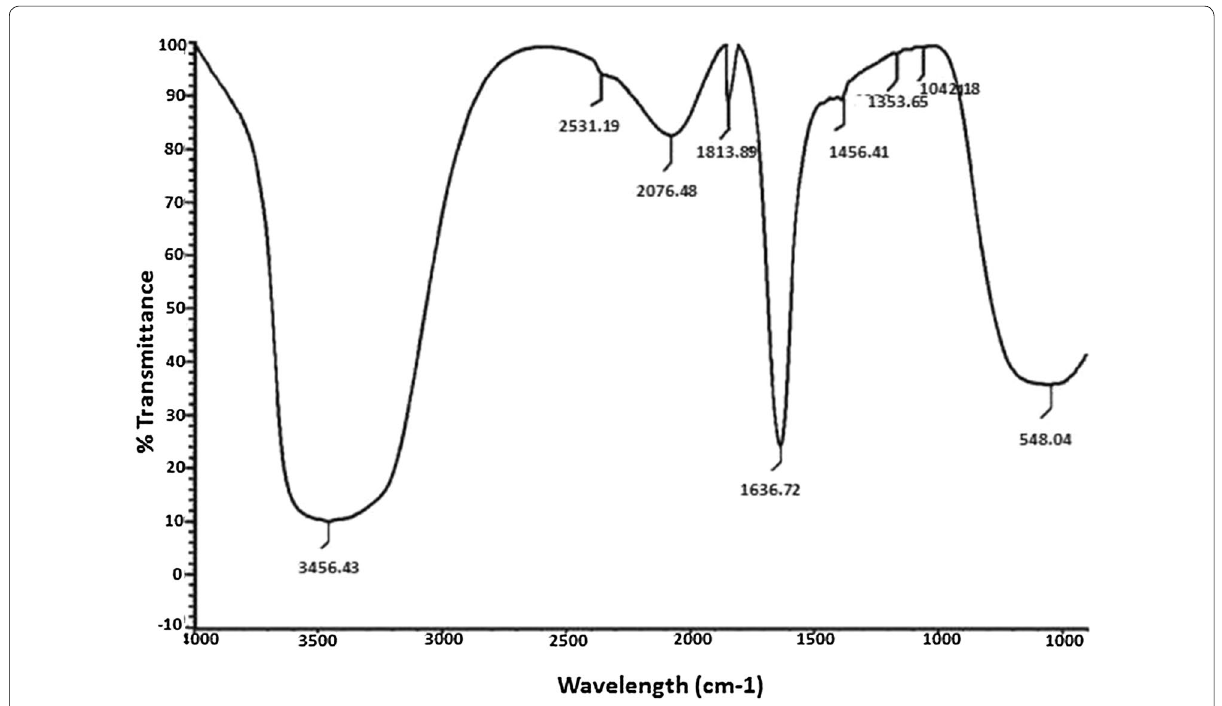
Fig. 4 FTIR spectrum of synthesized silver